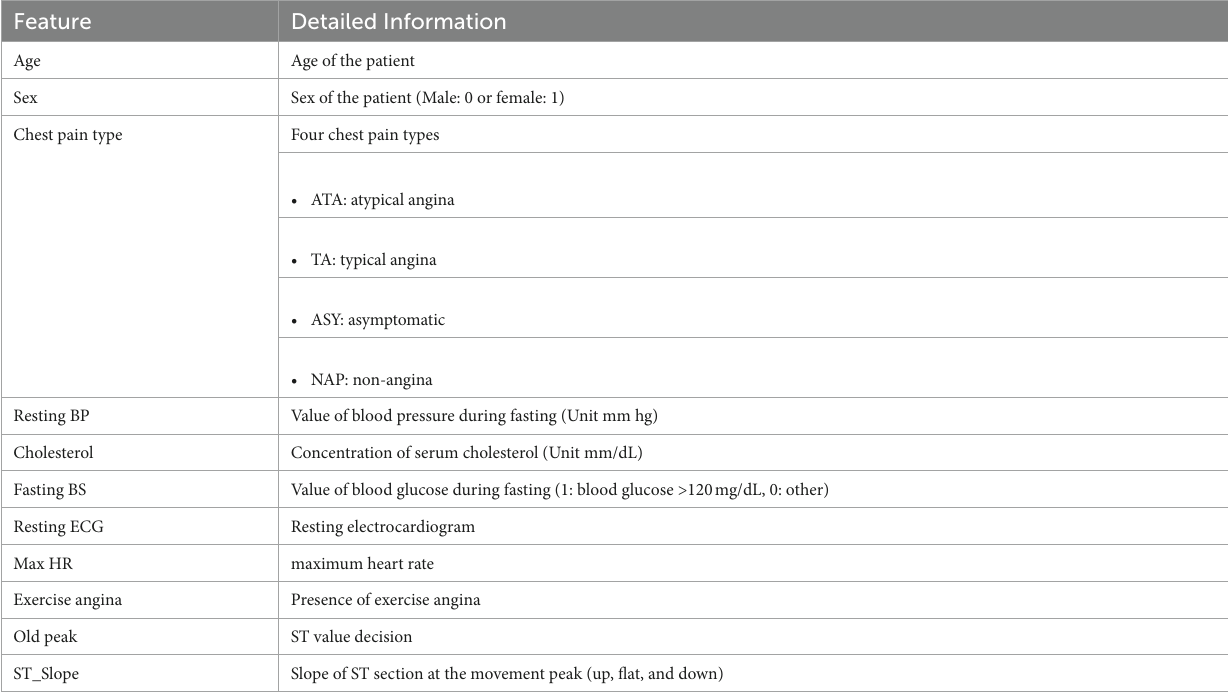
TABLE 1 Heart dataset